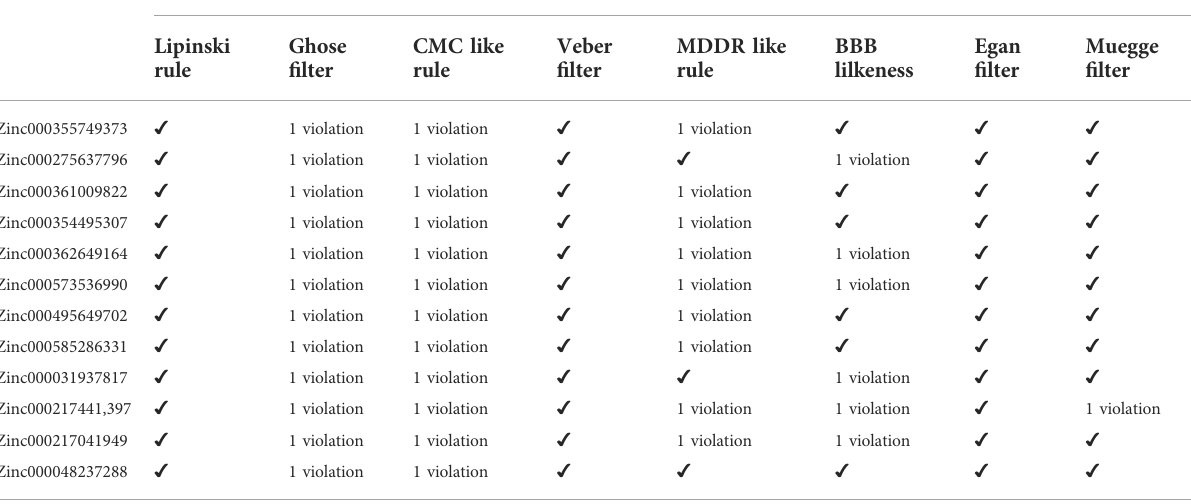
TABLE 4 Druglikeness assesments of topmost ligands using DruLiTo and SwissADME tools.